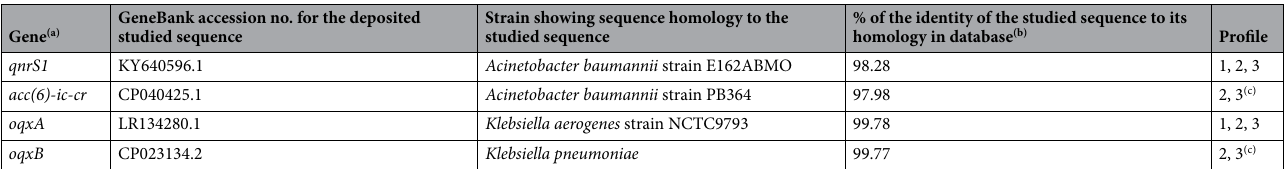
Table 5. The PAFQR gene amplicons sequences of some selected A. baumannii isolates and their identity to sequences deposited in GeneBank database. The level of significance for the % of identity of the studied sequence to its homology in database was mentioned. (a) no successful sequence of qnrA could be obtained although its amplicon was sent twice to different laboratories. (b) at p -value ≤ 0.05 level of significance. (c) these genes gave negative results with profile number 1